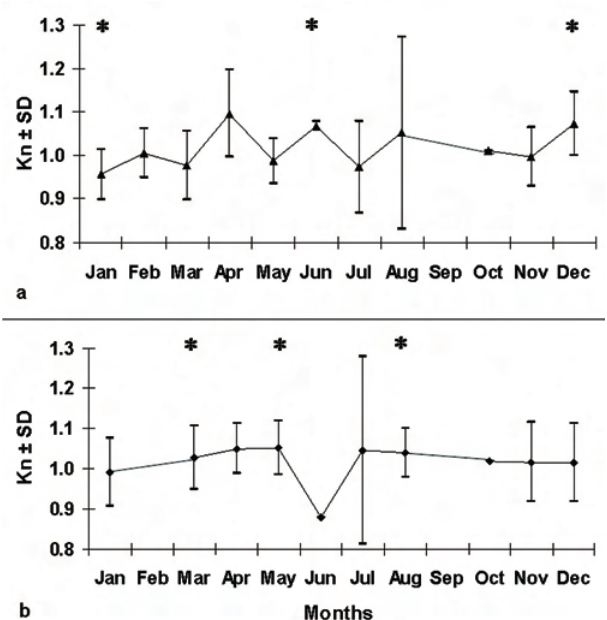
Fig. 5. Monthly variation of the mean relative condition factor values (Kn) ± Standard Deviation (SD) of Cichla kelberi females (a) and males (b), in Lobo Reservoir, during the study period. (Legend: * Kn of significantly different than